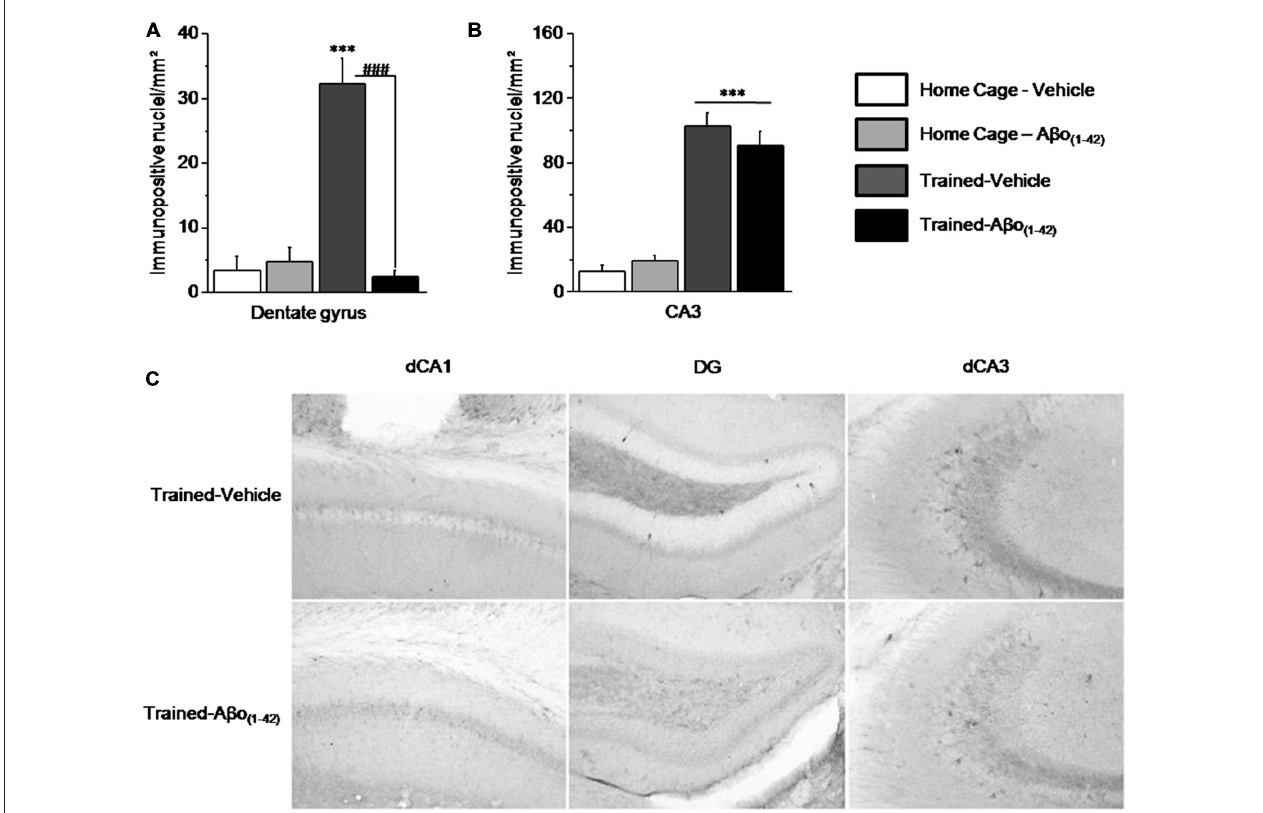
FIGURE 6 | Effects of intra-dCA1 A β o ( 1 – 42 ) injections on levels of phosphorylated ERK1/2 (pERK) in the dorsal hippocampus . Tested animals were killed 30 min after the beginning of the sequential alternation test session. Levels of pERK were measured in the dorsal DG and the dorsal CA3 from Vehicle-injected mice (home-cage: n = 5; Tested: n = 10) and A β o ( 1–42 ) -injected mice (home-cage: n = 5; Tested: n = 9). (A) Tested-related increase of pERK in the DG was abolished by A β o ( 1–42 ) injections. (B) In the dorsal CA3, A β o ( 1–42 ) had no effect on pERK levels in comparison with Vehicle, regardless of home-cage or tested conditions. (C) Representative photomicrographs of pERK immunoreactivity within the dCA1, DG and dCA3 of Trained-Vehicle (top) and Trained-A β o ( 1–42 ) (bottom) groups. ∗∗∗ : Test effect ; ### : Between-group comparisons